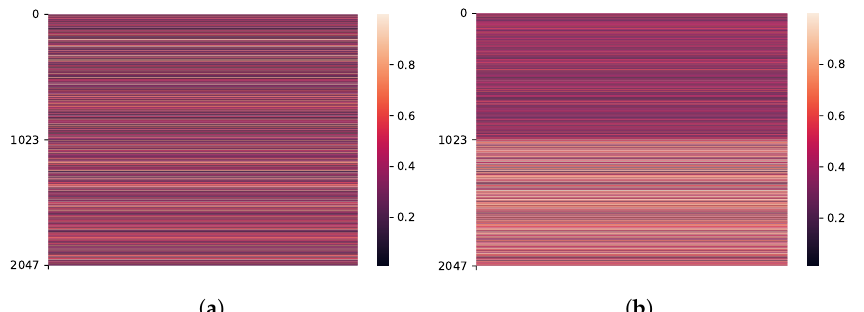
Figure 8. Channel-attention weight ( CA ∈ R 1 × 2 d emb ) under different training conditions. When the transcription becomes unreliable, the channel-attention block pays more attention to the refer- ence embedding. For the model trained with normal transcription ( a ), summed attention weight for the reference embedding dividing summed attention weight for the trainable embedding is ( ∑ 2 d emb CA c ) / ( ∑ d emb − 1 CA c ) = 1.02. In contrast, for the model trained with randomly generated c = 0 c = d emb CA c ) / ( ∑ d emb − 1 CA c ) = transcription ( b ), ( ∑ 2 d emb c = 0 c = d emb